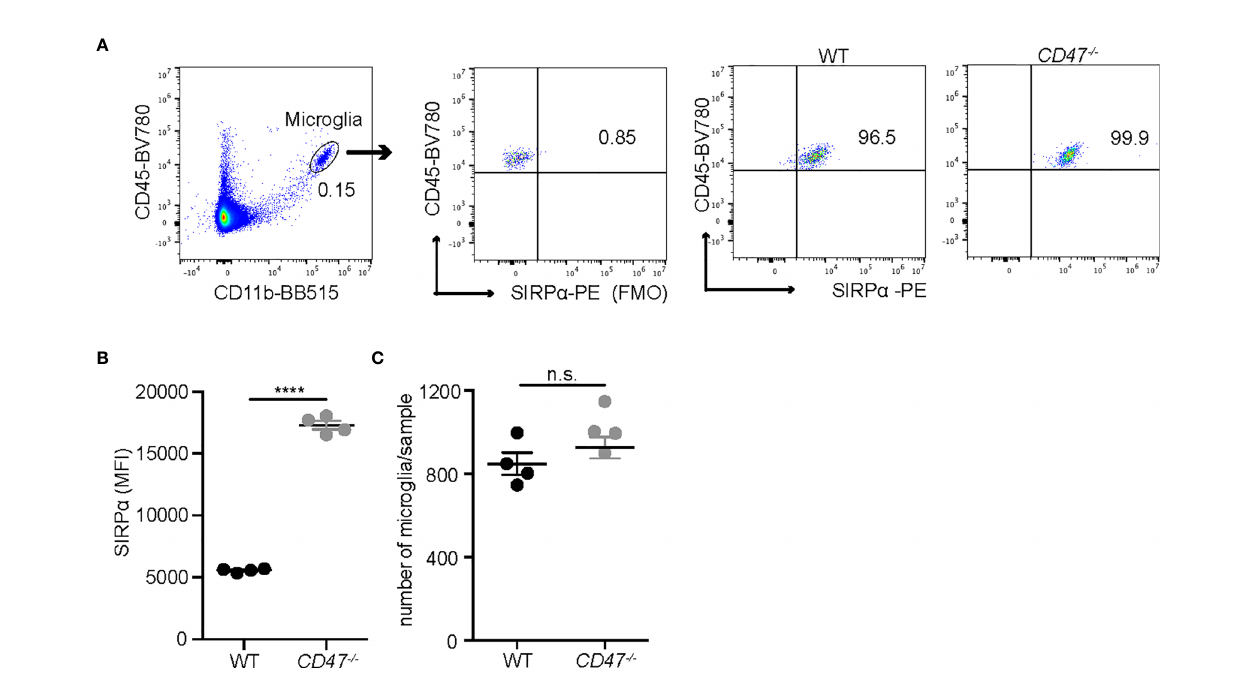
FIGURE 2 | SIRP a expression on retinal microglia is upregulated in naïve CD47 -/- mice. Retinal microglia are isolated from naïve WT and CD47 -/- mice. Both retinas from one mouse were combined and processed as one sample. Retinal single cell suspensions were gated on live cells (DAPI - ). SIRP a expression on microglia (CD11b + CD45 low ) was examined by fl ow cytometry. (A) The gating strategy of microglia and SIRP a , and representative sample from each group. (B) MFI of SIRP a on microglia. (C) The number of microglia per sample (contains two retinas). Data were analyzed by Student ’ s t test and expressed as mean ± SEM. ****P<0.0001. n.s., not signi fi cant. n=4 mice per